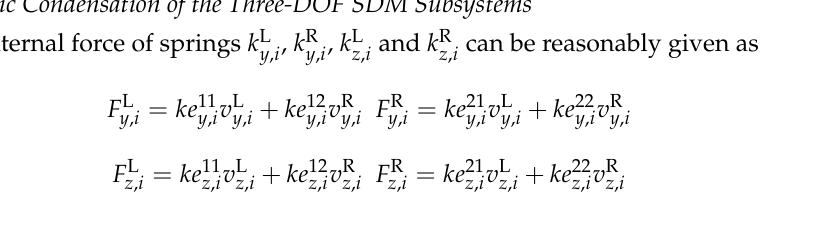
Figure 2. ( a ) The cross section of the thin-walled beam system at the connection point; ( b ) the three- DOF SDM subsystems is condensed into eight complex effective stiffness via dynamic condensation.